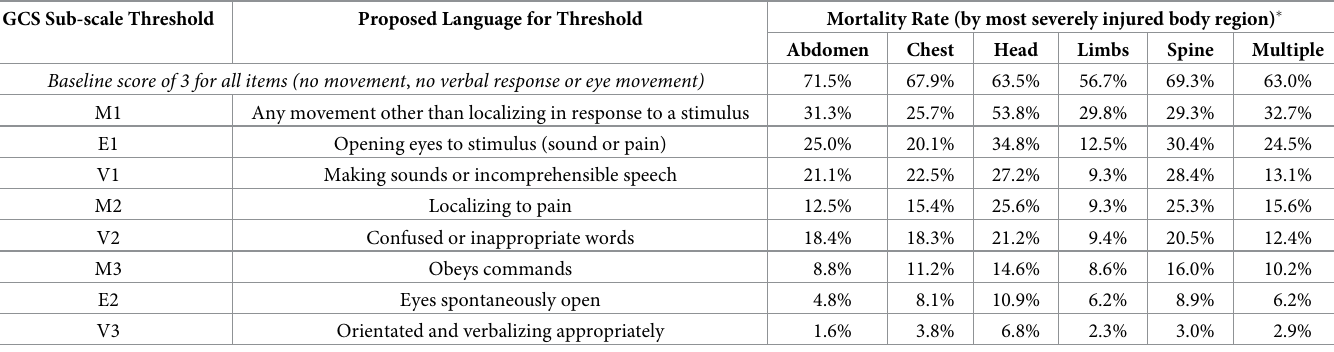
Table 7. Re-scored GCS sub-scales organized by interval logit